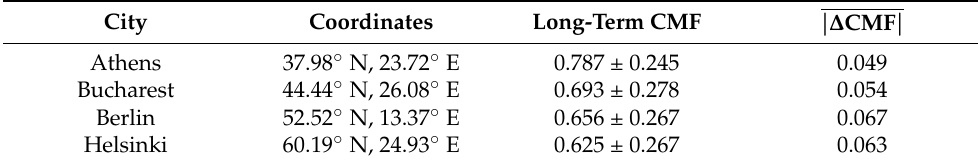
Table 1. Four chosen cities with their coordinates, long-term cloud modification factor (CMF, mean ± standard deviation from 2004 to 2019), and mean absolute change of CMF from the previous one time step to the present.